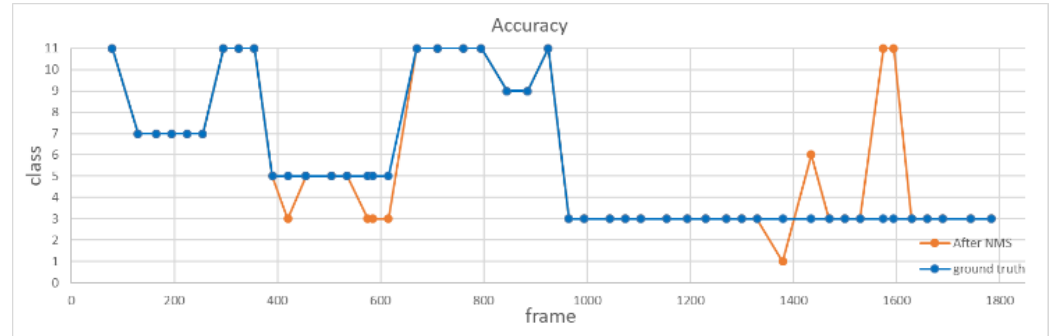
Figure 17. Performance of action recognition of the overall system.